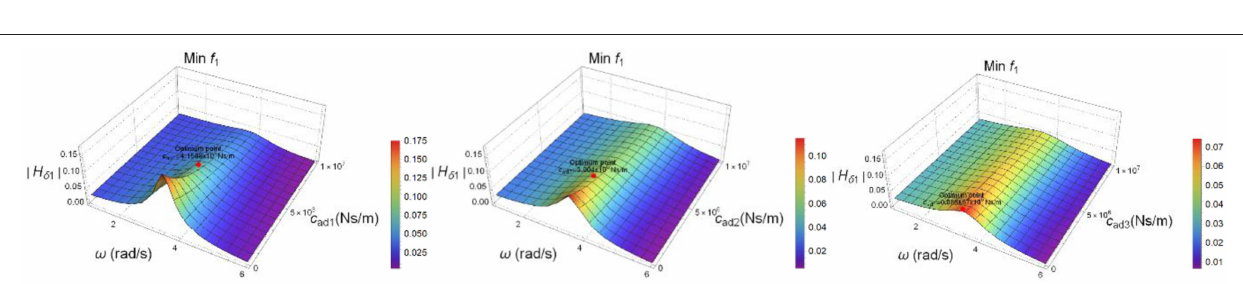
H δ 6 based on f 1 , minimization with respect to excitation frequency and added damping parameters. (cid:12) (cid:12) (cid:12) (cid:12)